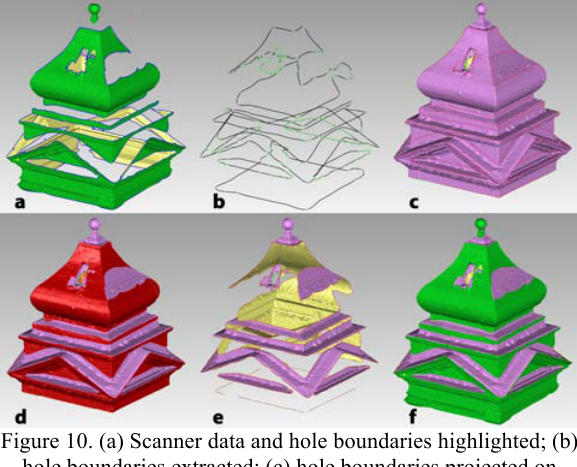
Figure 10. (a) Scanner data and hole boundaries highlighted; (b) hole boundaries extracted; (c) hole boundaries projected on UAV data; (d) selection of overlapping areas on UAV data using projected boundaries; (e) UAV data fitting scanner data holes; (f) scanner data merged with UAV data.